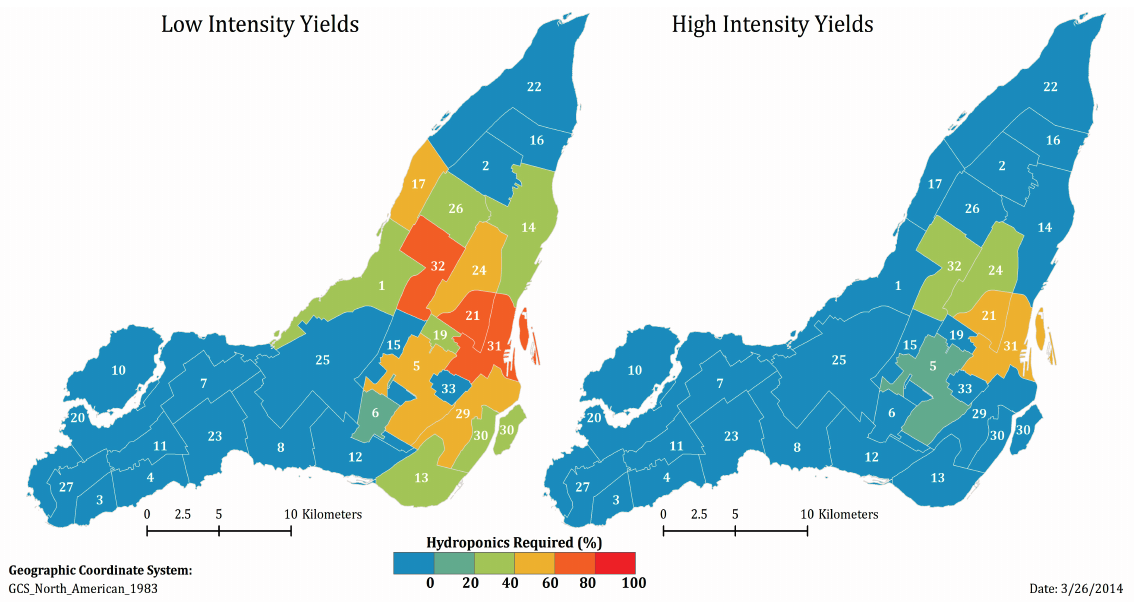
Figure 2. Percentage of hydroponics needed to reach vegetable demand after maximizing the use of vacant and residential yard space for low-intensity or high-intensity vegetable production. See Table 4 for the borough key.